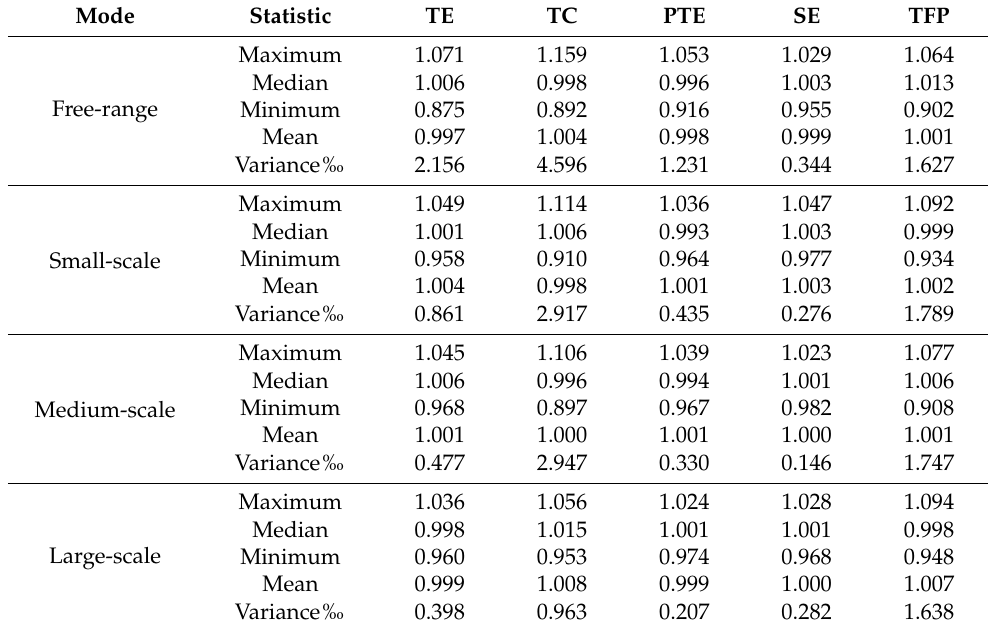
Table 2. Statistics of TFP and its composition of raw milk from 2004 to